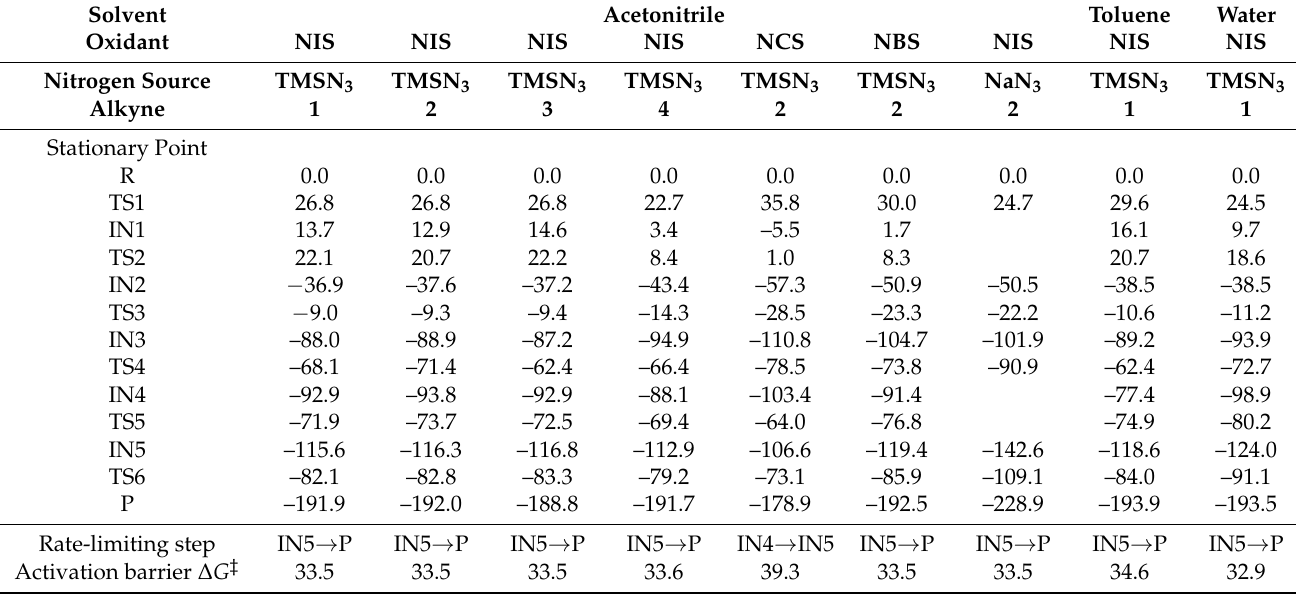
Table 1. Relative Gibbs free energies of stationary points during the alkyne → nitrile conversion shown in Figure 2 (in kcal mol − 1